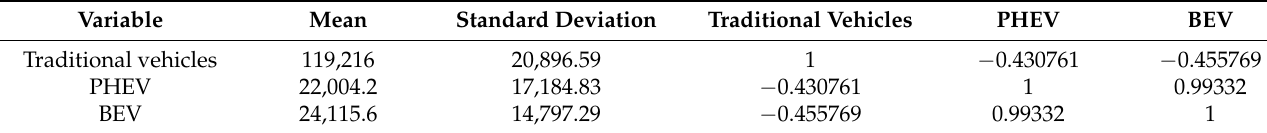
Table 3. Statistical values of individual variables in the overall summary.